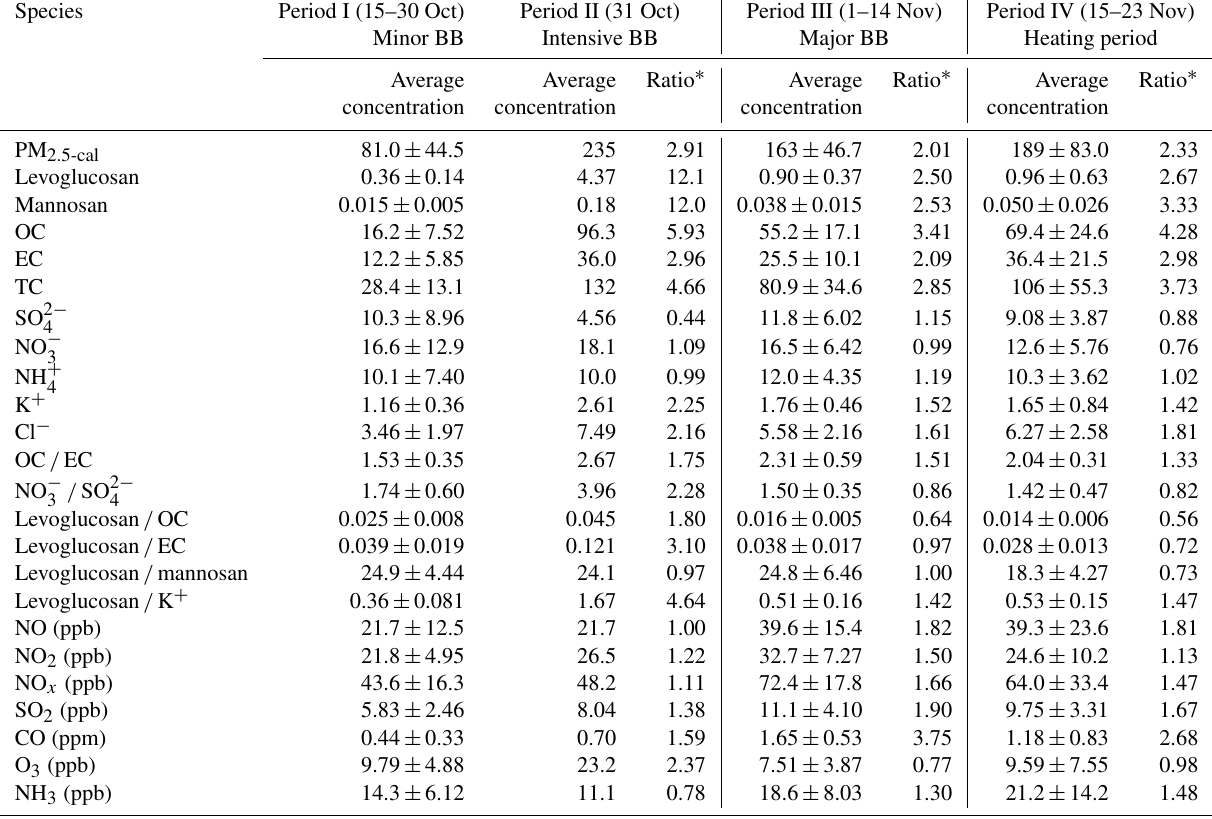
Table 2. Concentrations of chemical components in PM 2 . 5 aerosols as well as their ratios and gaseous species collected at the GC site during the four biomass burning periods (i.e., minor, intensive, major BB and heating periods) from 15 October to 23 November